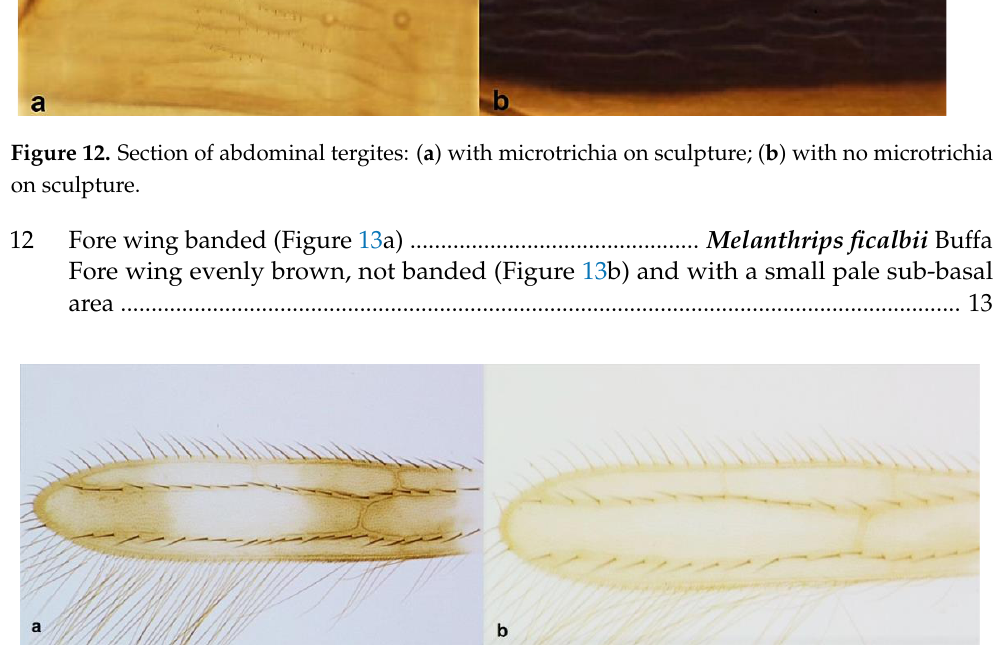
Figure 13. Fore wing: ( a ) banded; ( b ) not banded.